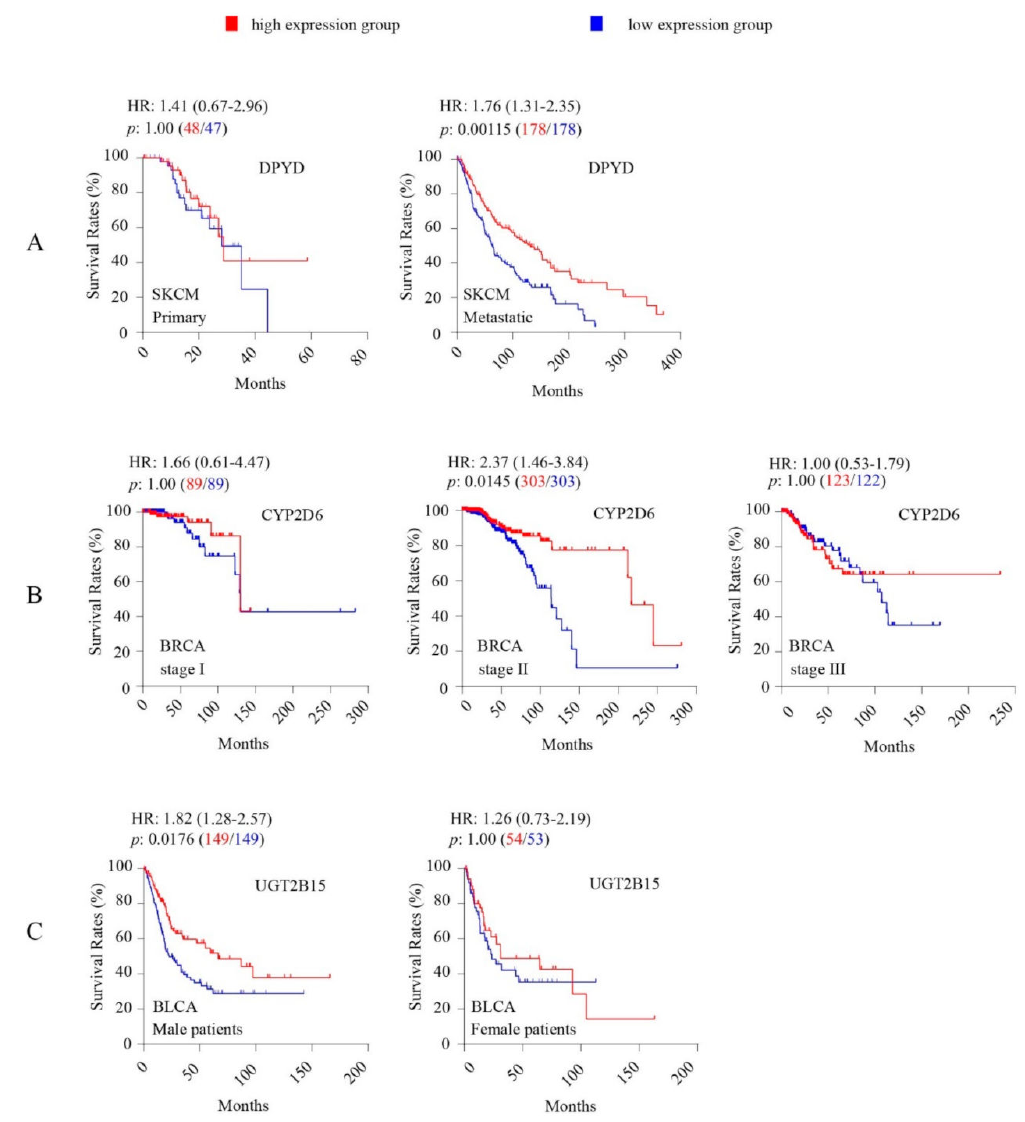
Figure 2. Kaplan-Meier survival analysis and Logrank test show significant associations of intratumoral expression levels of dihydropyrimidine dehydrogenase (DPYD) in skin cancer SKCM (stratified by tumor type) ( A ), CYP2D6 in breast cancer BRCA (stratified by tumor stage) ( B ), and UGT2B15 in bladder cancer (stratified by sex) ( C ) with overall survival rates. For Kaplan-Meier survival analysis, the patients were separated into high-expression group (upper 50 percentile, red curve) and low-expression group (lower 50 percentile, blue curve) by gene expression levels in each TCGA cancer type as indicated. The number of patients in each group was given in bracket following the p -value. A Bonferroni-corrected cuto ff logrank p -value of < 0.05 indicates statistical